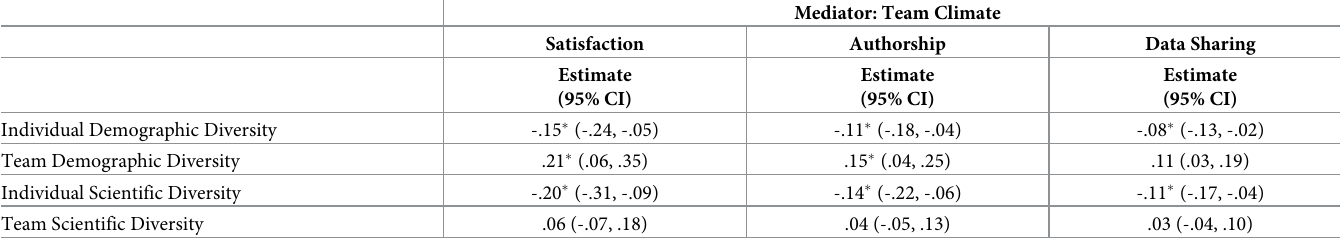
Table 4. Indirect effects of individual demographic diversity, team demographic diversity, individual scientific diversity, and team scientific diversity on satisfac- tion, authorship, and data sharing through the team climate